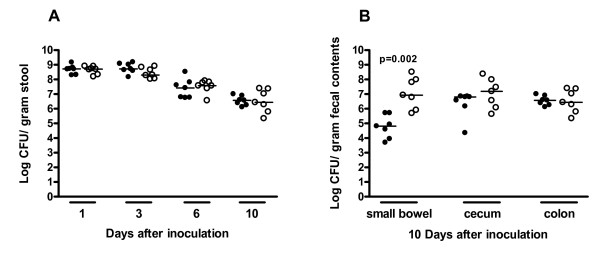
Intestinal colonization. Mice were orally inoculated with E1162 (black circles) or E1162Δesp (open circles). (A) Numbers of E1162 and E1162Δesp were determined in stool of mice at different time points after E. faecium inoculation. (B) After 10 days of colonization, numbers of E1162 and E1162Δesp were determined in small bowel, cecum and colon. Data are expressed as CFU per gram of stool/fecal contents and medians are shown for 7 mice per group.